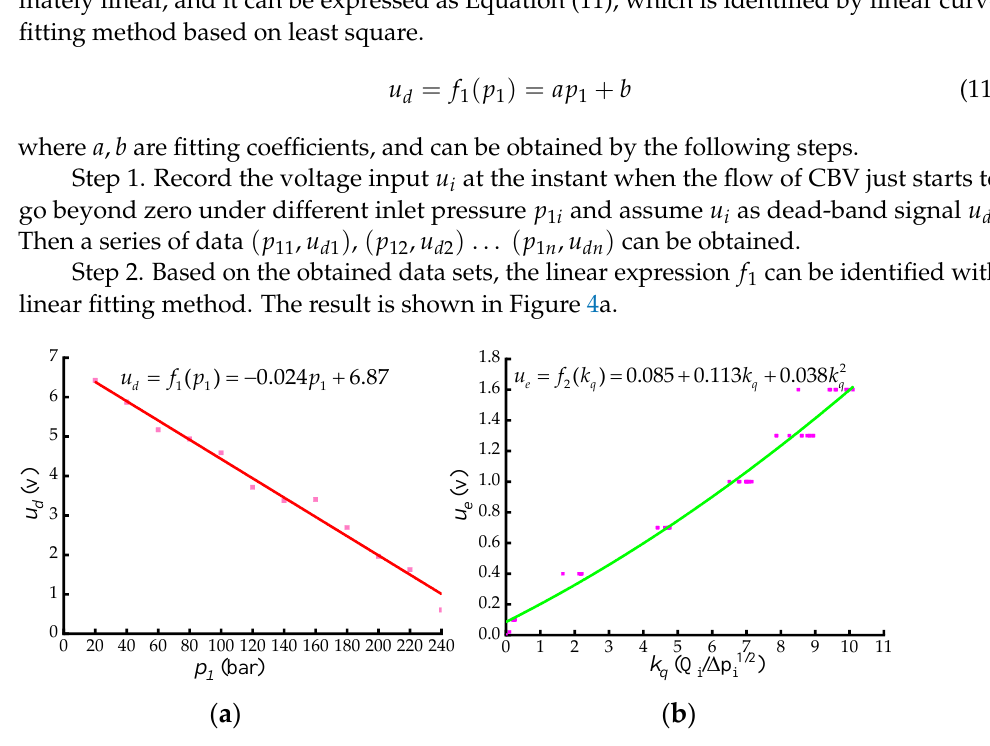
Figure 4. ( a ) Linear fitting curve for dead-band vs. inlet pressure of EPCBV, ( b ) polynomial fitting curve for effective signal vs. flow gain of EPCBV.